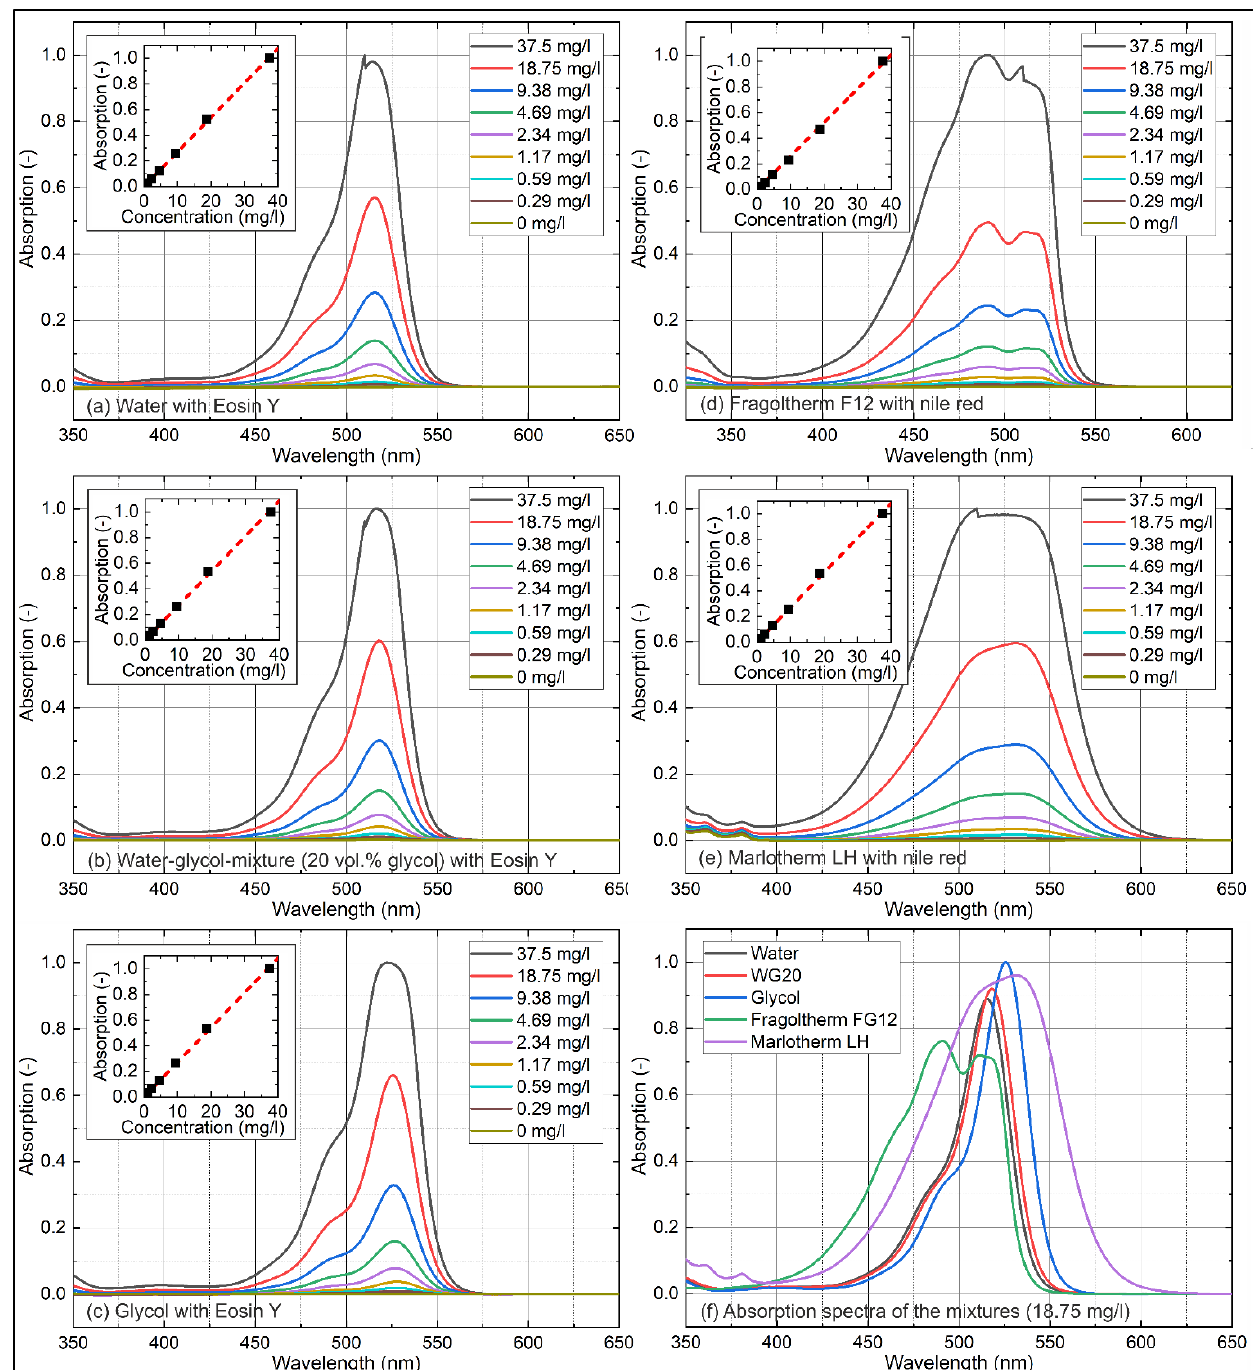
Figure 2. Concentration-dependent absorption spectra of Eosin-Y ( a – c ) and Nile red ( d , e ) in various solvents; comparison of absorption spectra of Nile red and Eosin-Y in various liquids at a fixed tracer concentration of 18.75 mg/L ( f ), 293 K.